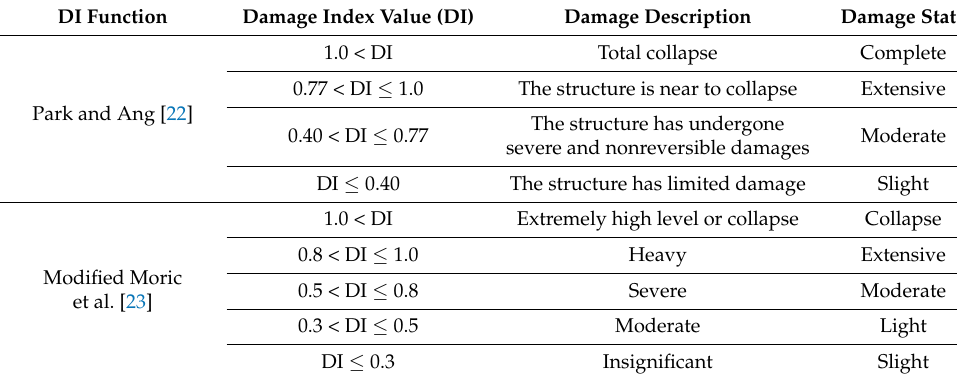
Table 3. DI values and damage description. DI